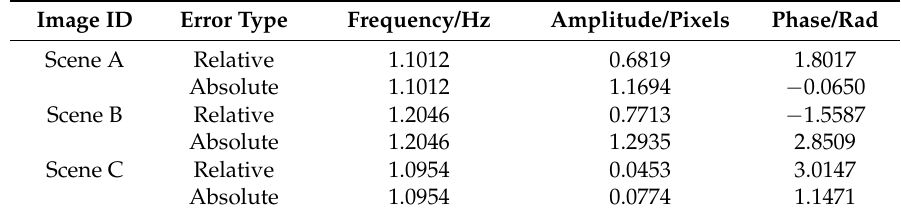
Figure 11. Relative time-varying errors across the track between B1 and B2 of ( a ) Scene A, ( b ) Scene and ( c ) Scene C using refined parallax images. B, and ( c ) Scene C using refined parallax images. Table 4. Detected results using B1–B2 Table 4. Detected results using B1–B2 images.